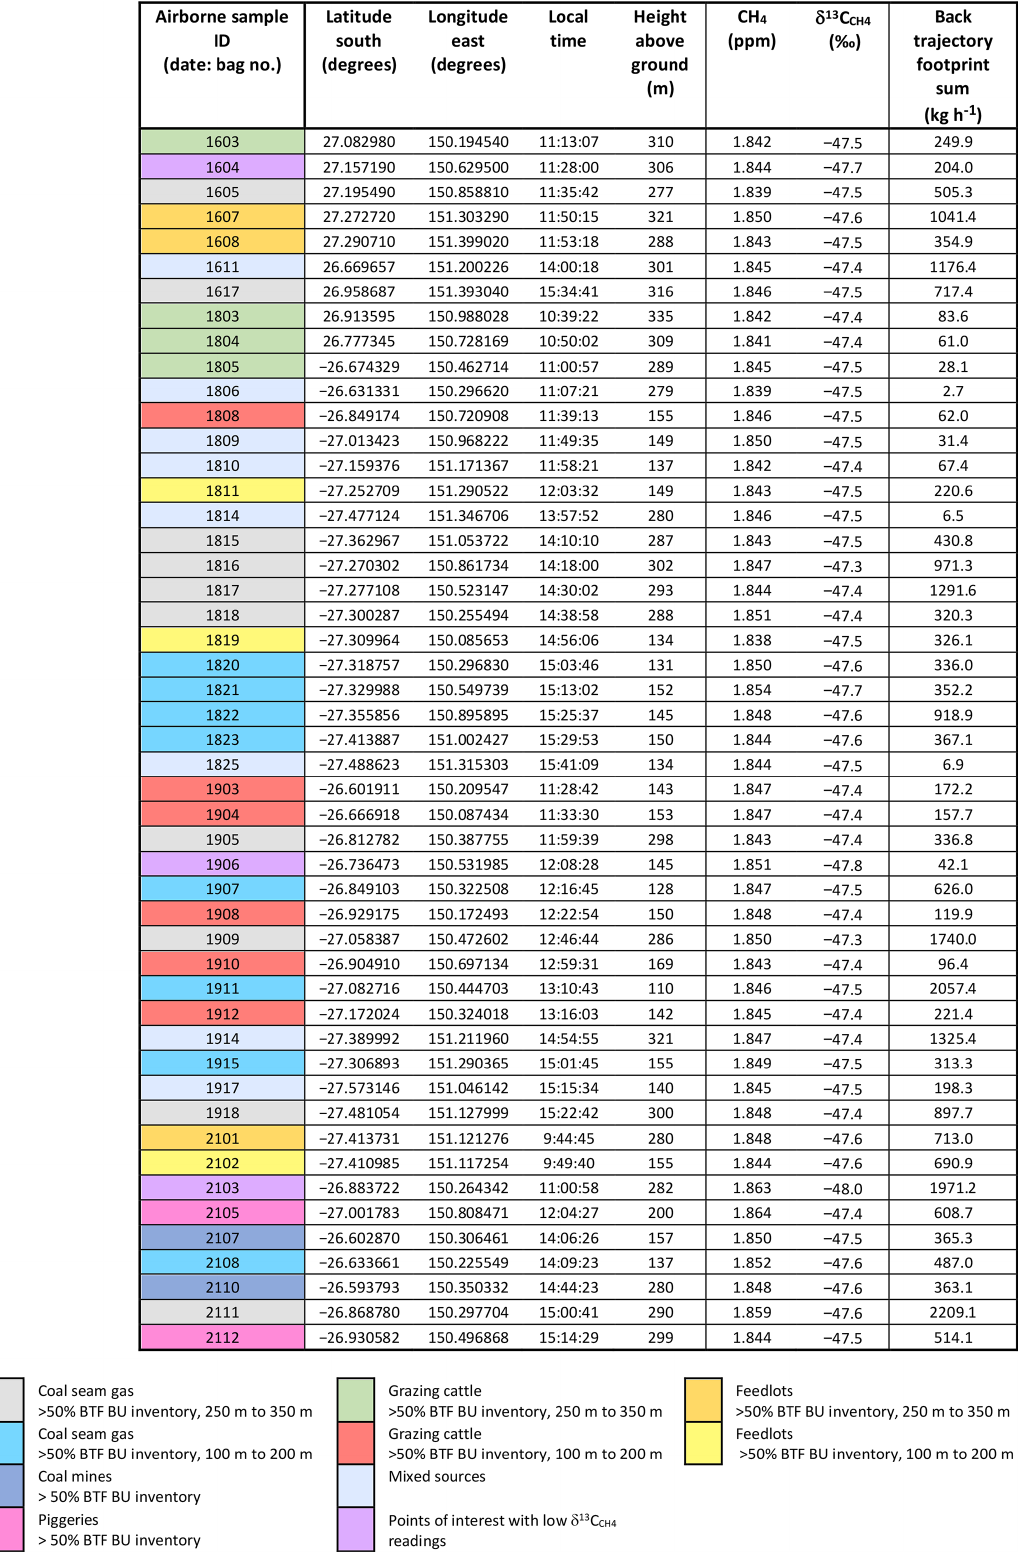
Table A2. In-flight atmospheric air sample location details and UNSW bottom–up inventory CH 4 emissions estimates within the 2h back- trajectory